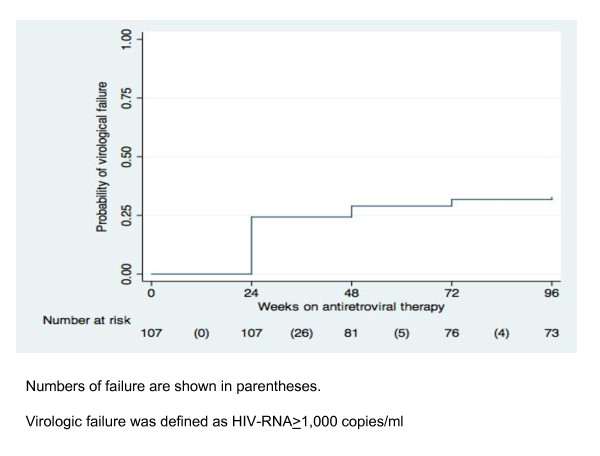
Kaplan-Meier proportion of virologic failure.